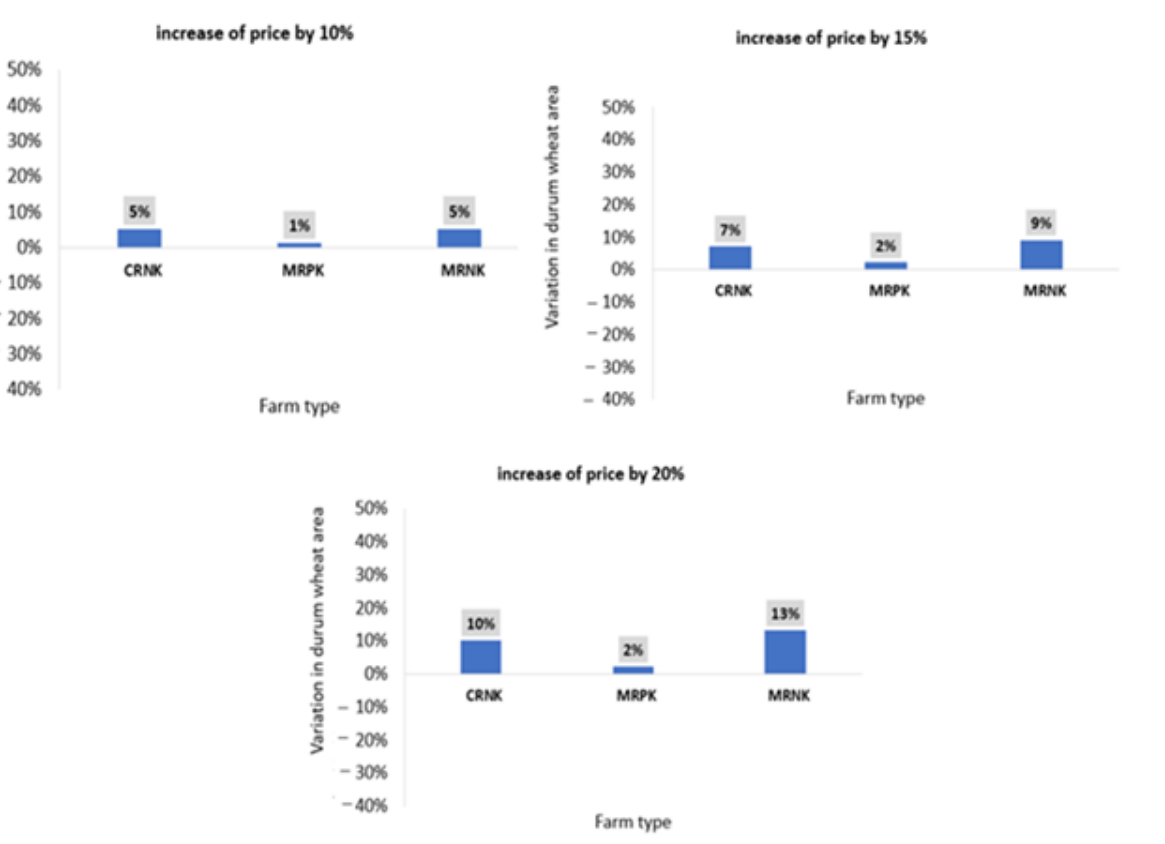
Figure 6. Variation in durum wheat area under increased cereal price scenario (S2).